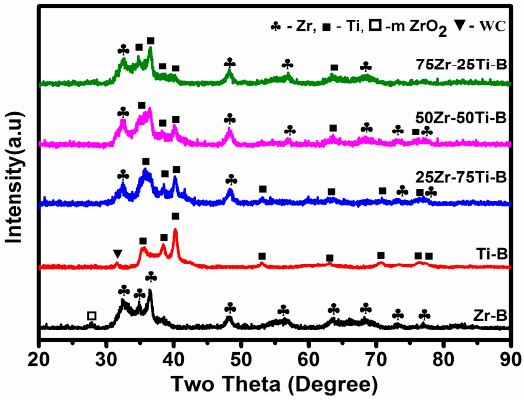
Figure 2. XRD of 8 h ball milled elemental powders.